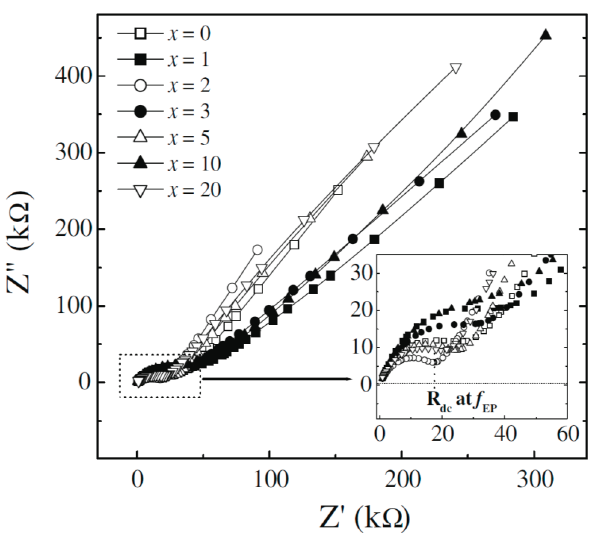
Figure 15. Z ” versus Z ’ plots of PEO–LiClO 4 (EO:Li + = 20)– x wt % MMT CPEs. The inset shows an enlarged view of the higher-frequency region. Reproduced with permission from Choudhary et al. [152]. Copyright 2011, National Institute of Science Communication and Information Resources.